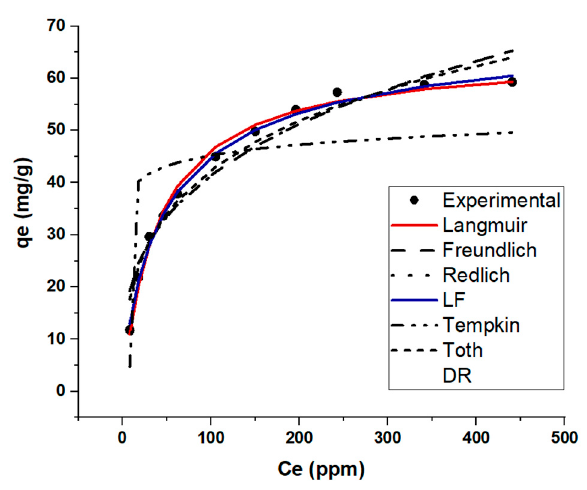
Figure 5. Isotherm modelling results of KBS: MB adsorption capacity at equilibrium (qe) Vs. final concentration.